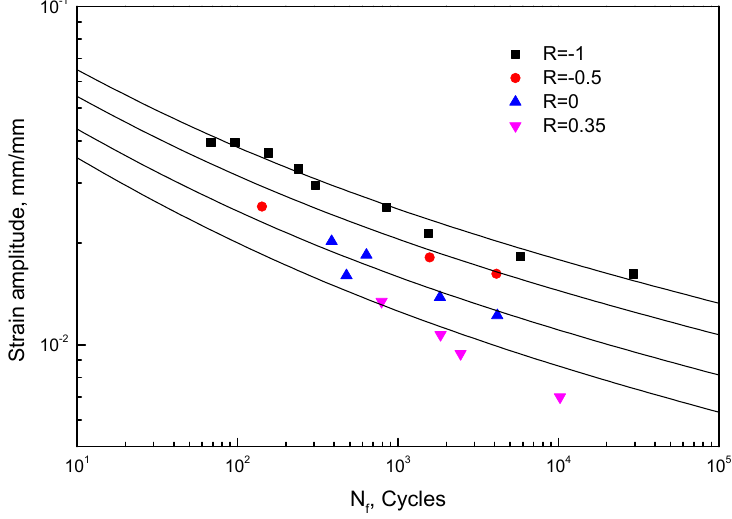
Figure 7. LCF lives of 2124-T851 under different strain ratios.